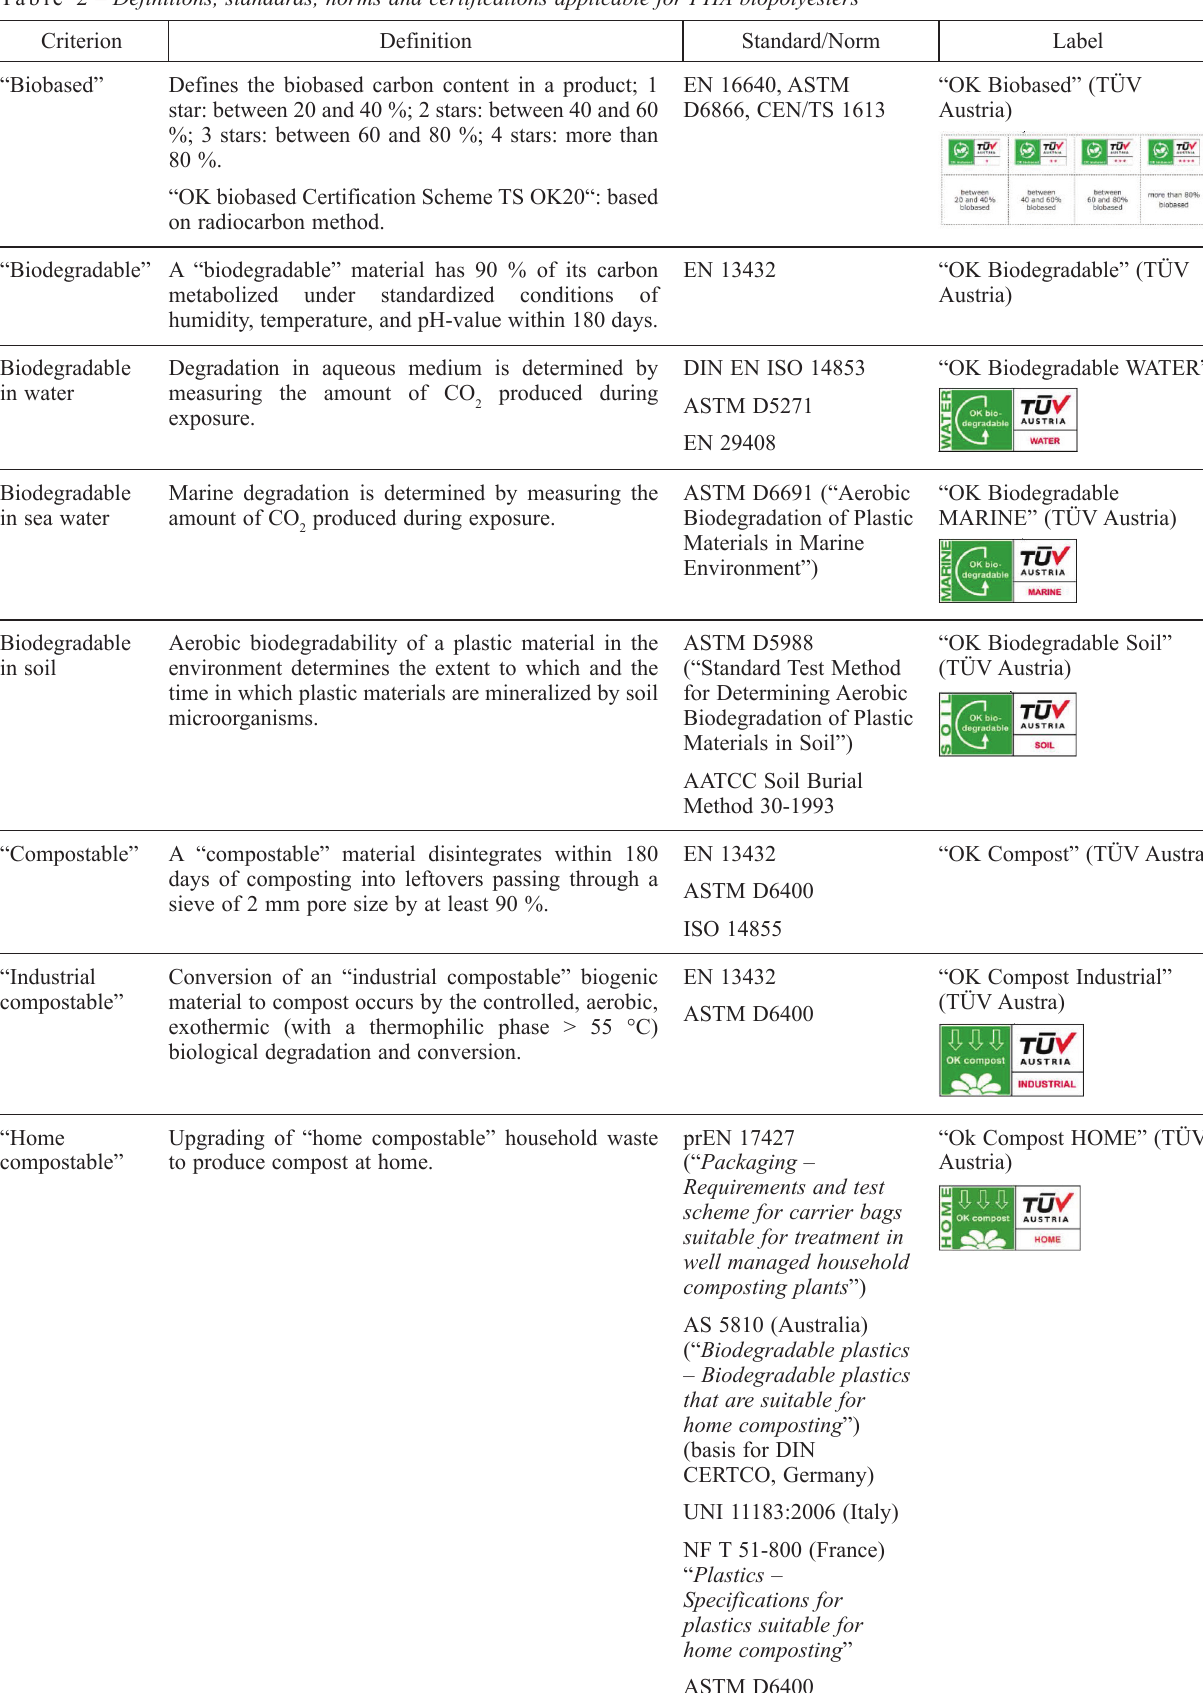
Table 2 – Definitions, standards, norms and certifications applicable for PHA